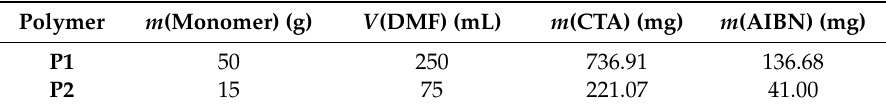
Table 1. Summary of the utilized amounts and volumes for the Reversible Addition-Fragmentation Chain Transfer (RAFT) polymerizations of methyl methacrylate (MMA).